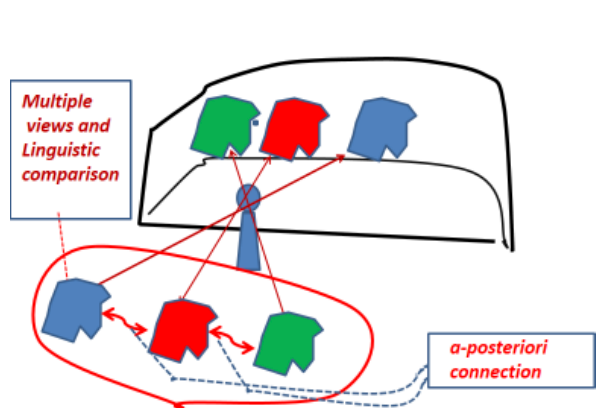
Figure 2. In linguistic operations, humans code a perception in a linguistic code andretrieve it by short term memory (around 3 sec)comparing it to a successive coded perception. From the com- parisonit emerges a connection that increases the details of the observed